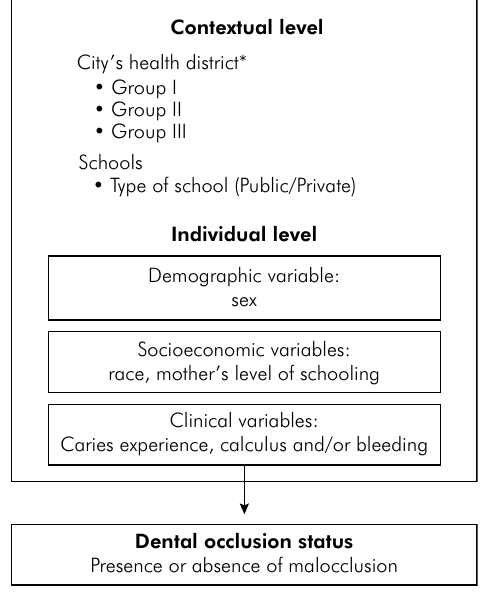
Figure. Multilevel model of the association between individual and contextual variables and dental occlusion status of 12-year- old schoolchildren. Goiânia-GO, Brazil,